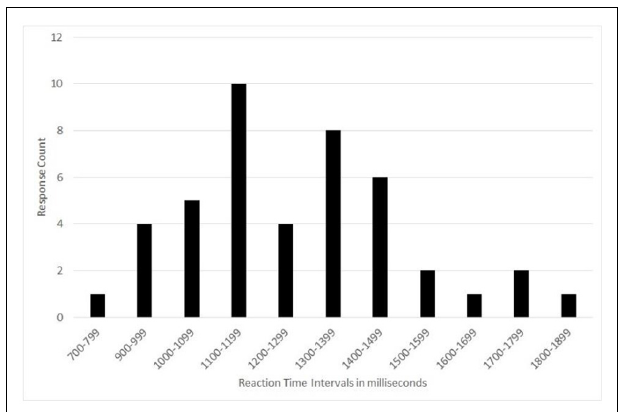
FIGURE 2 | Number of participants vs. reaction time intervals during the reaction time tests showing an asymmetric Gaussian distribution.